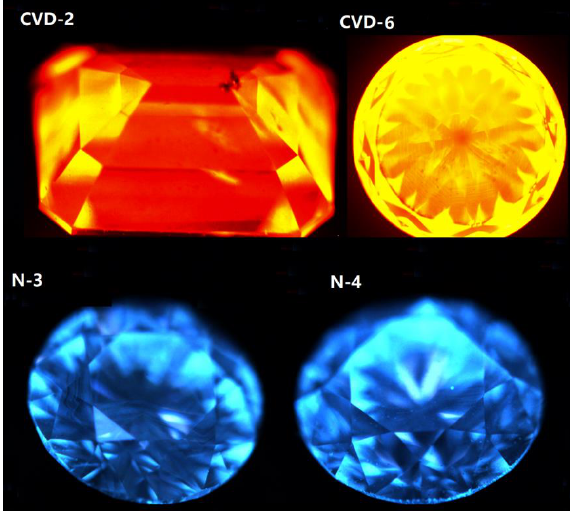
Figure 9. Different growth structures of samples under DiamondView.